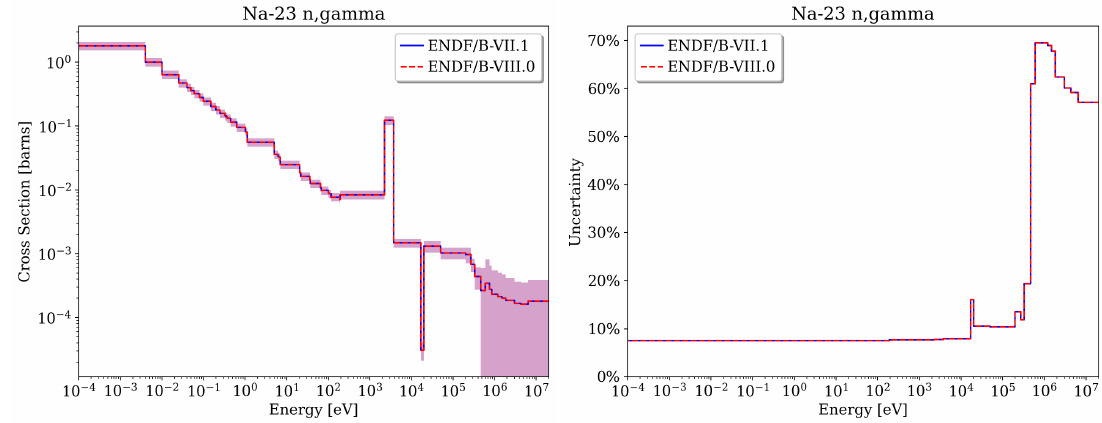
Figure A2. 23 Na (n, γ ) nominal data and